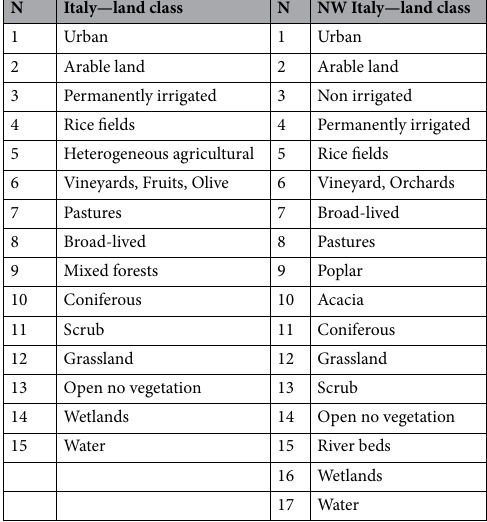
Table 1. Land use classes utilized in the species distribution models. For all of Italy land classes obtained from CORINE 2006 at 1:100,000 scale, and for NW Italy land classes obtained from PTF at 1:10,000